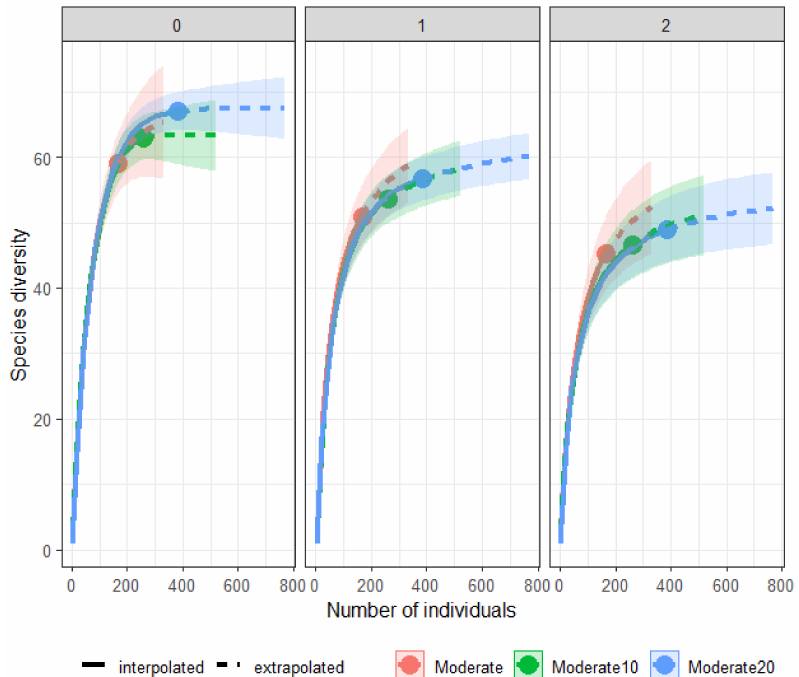
Figure 7. Comparison of tree species biodiversity between different sites under moderate utilization management regime based on Hill numbers for different orders (0, 1, and 2). The solid and dotted line represent the rarefaction and extrapolation curves, respectively. The shaded area indicates the confidence interval at 95%, based on bootstrap method with 200 replications.